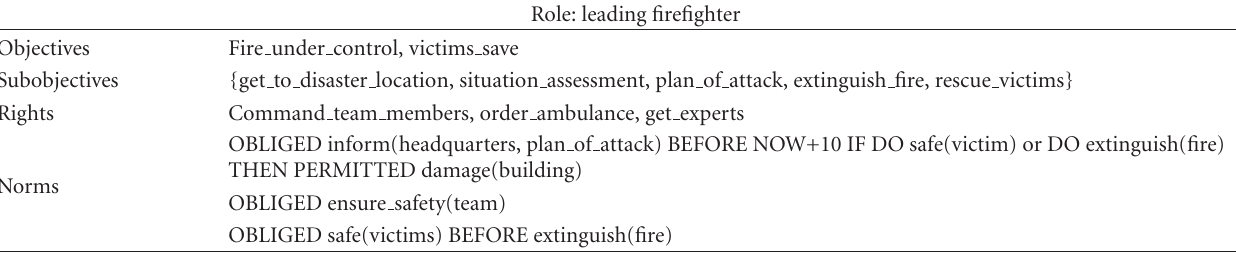
Table 2: Role definition in OperA.